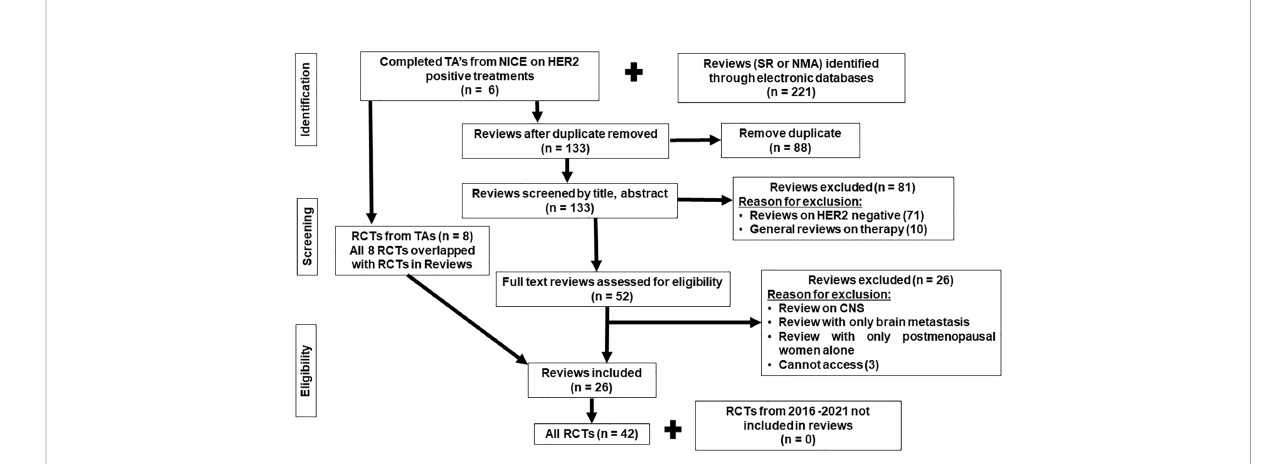
FIGURE 1 PRISMA fl owchart of randomized controlled trials (RCTs) included in the